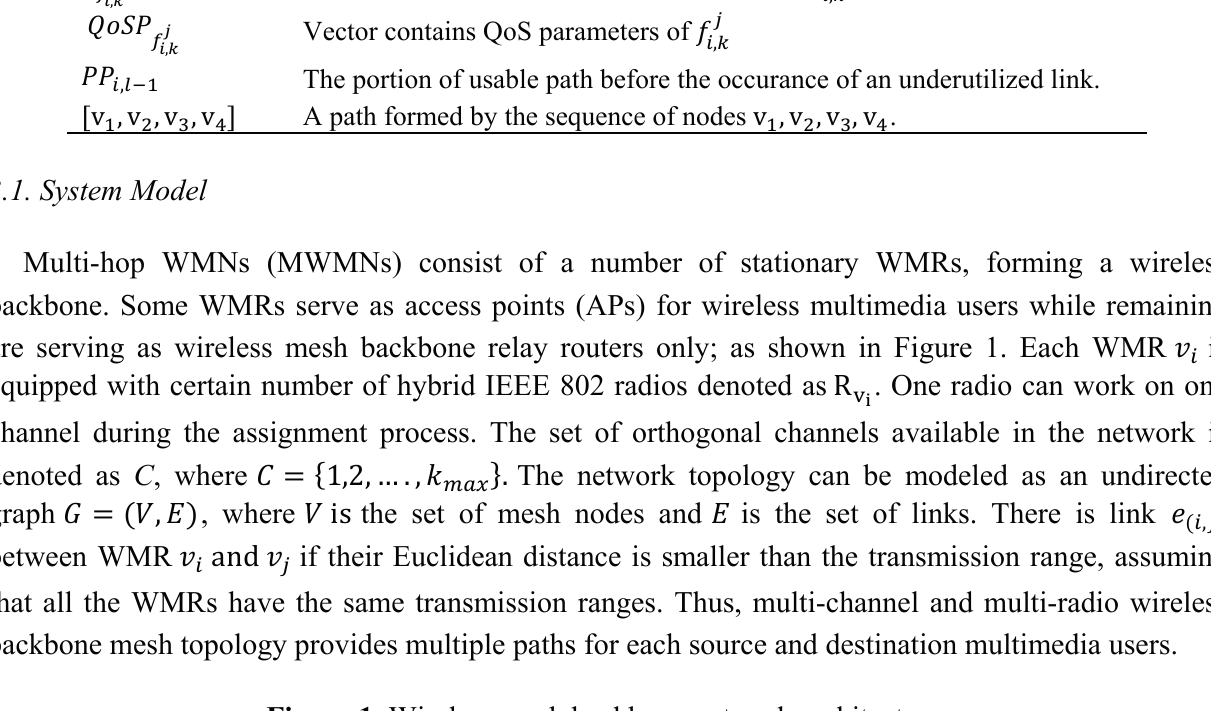
Figure 1. Wireless mesh backbone network